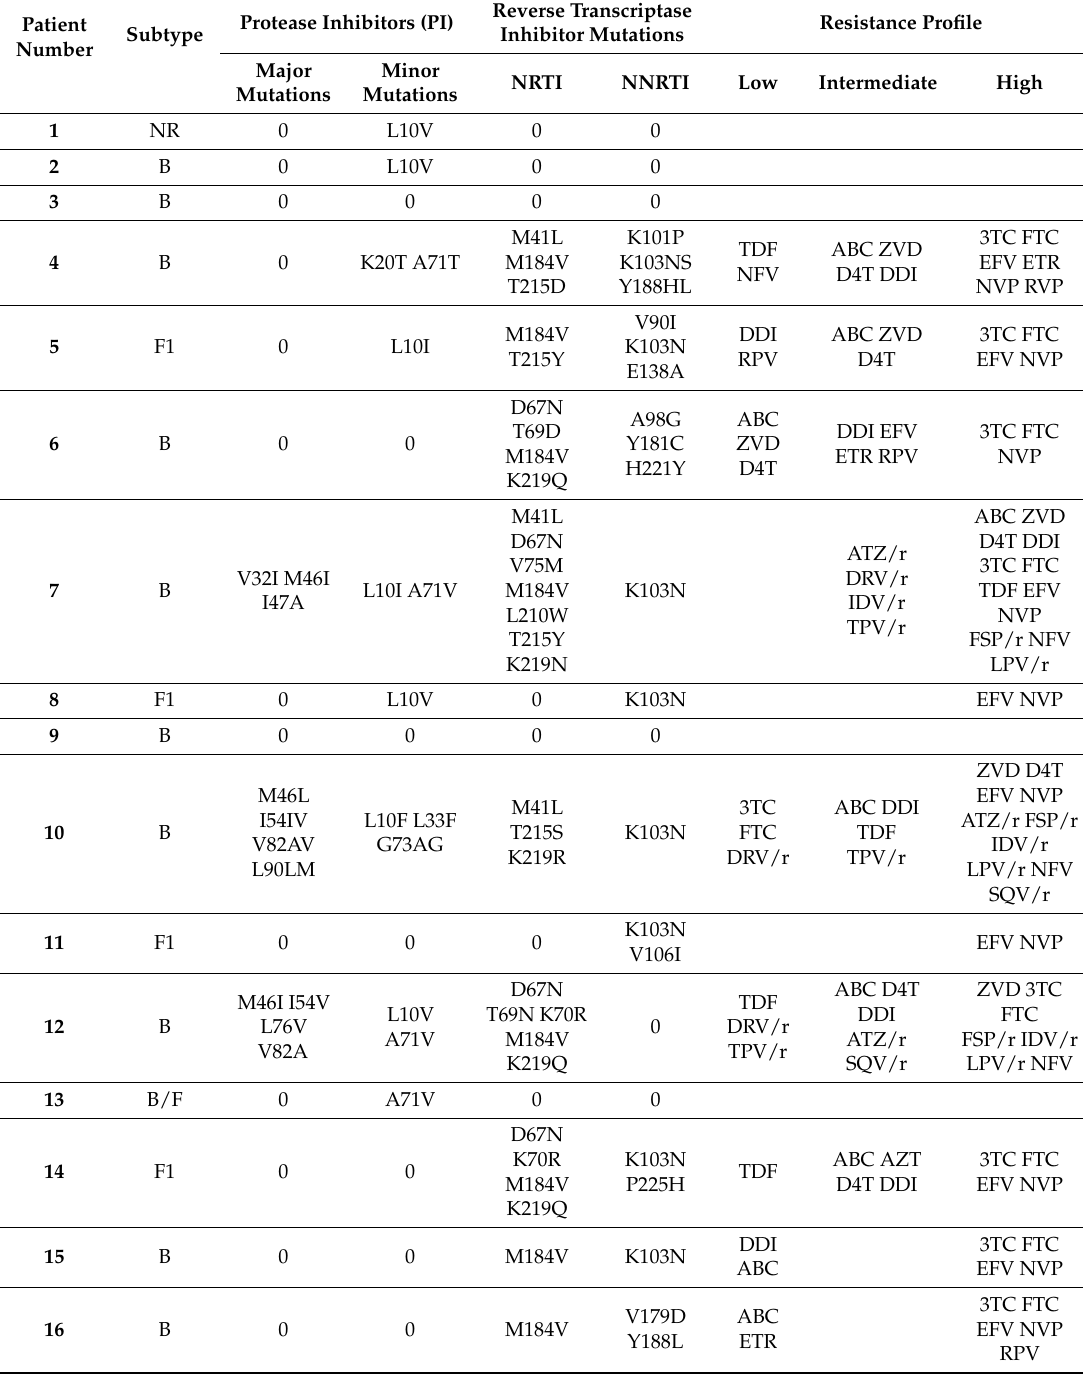
Table 1. Genotypic resistance mutations identified and antiretroviral resistance profile in pregnant women with perinatally-acquired HIV